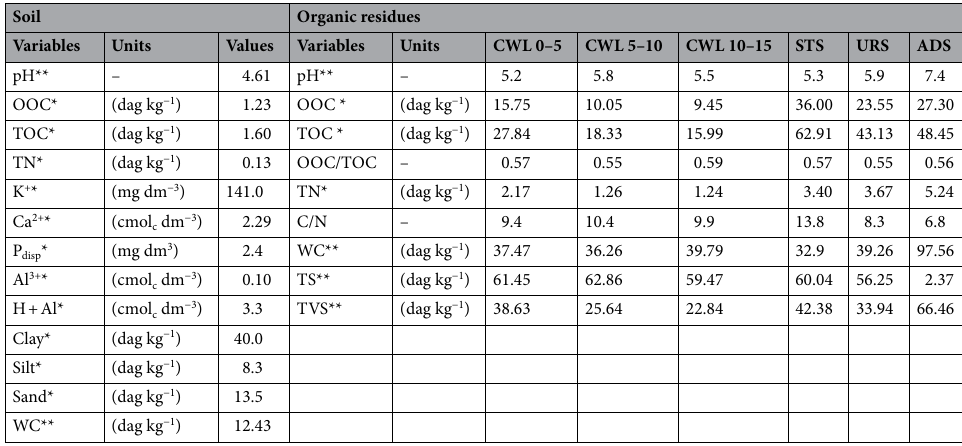
Table 1. Chemical and physical characteristics of the soil (air dried fine earth) and the organic materials collected at the depths of 0–5 cm (CWS 0–5), 5–10 cm (CWS 5–10) and 10–15 cm (CWS 10–15) of the VF-CW as well as septic tank sludge dewatered in a drying bed (STS), UASB reactor sludge dewatered in a drying bed (URS) and anaerobic digester sludge that was not dewatered in a drying bed (ADS). OOC easily oxidizable carbon, TOC total organic carbon, TN total nitrogen, K potassium, Ca calcium, P phosphorus, Al aluminum, H + Al potential acidity, WC water content, TS total solids, TVS total volatile solids. *Quantified on a dry basis. **Quantified on a wet